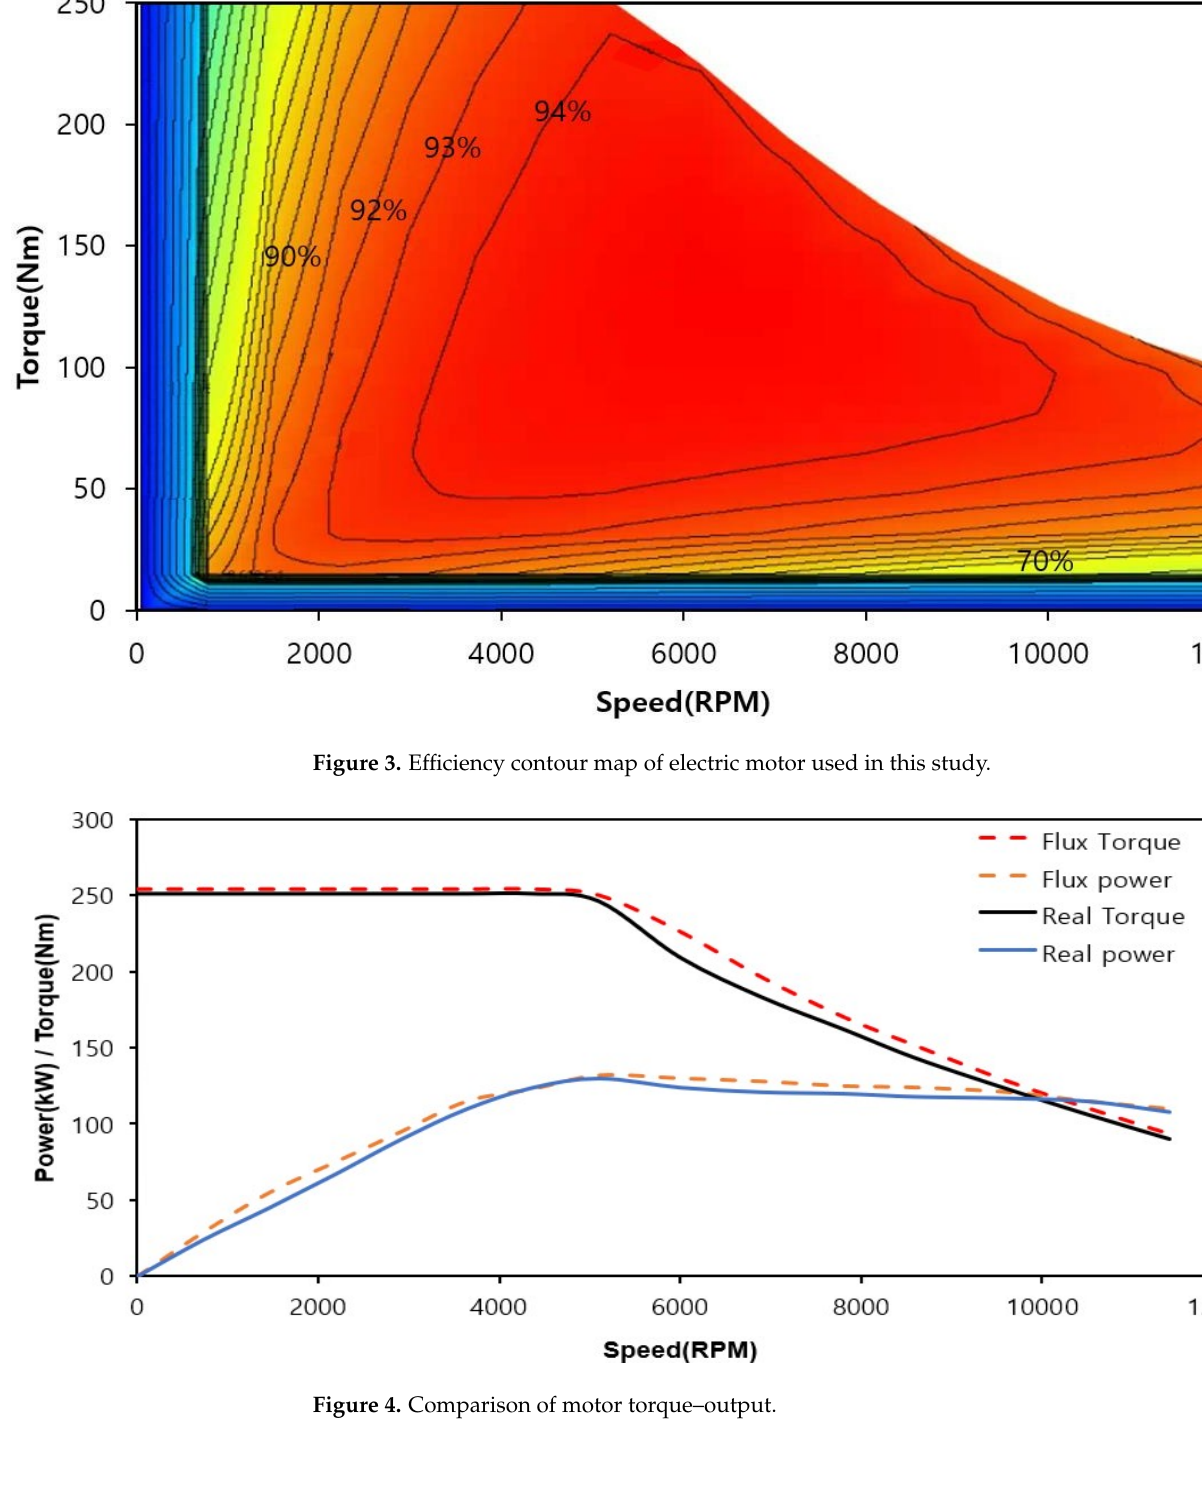
Figure 5. Battery voltage–SOC drop curve.